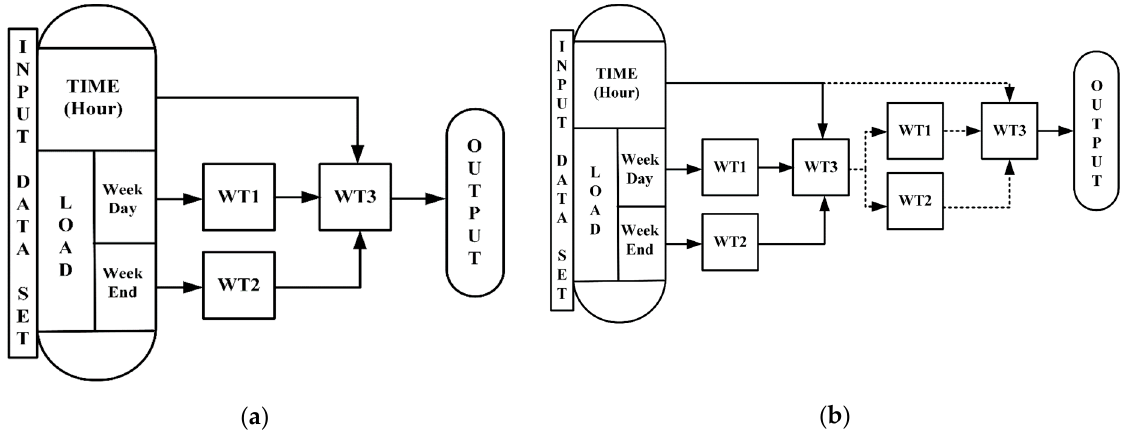
Figure 2. Proposed wavelet-based ensemble model: ( a ) Proposed wavelet diagram for Model 1, 2, and 3; ( b ) Proposed wavelet diagram for model 4 (M4) .